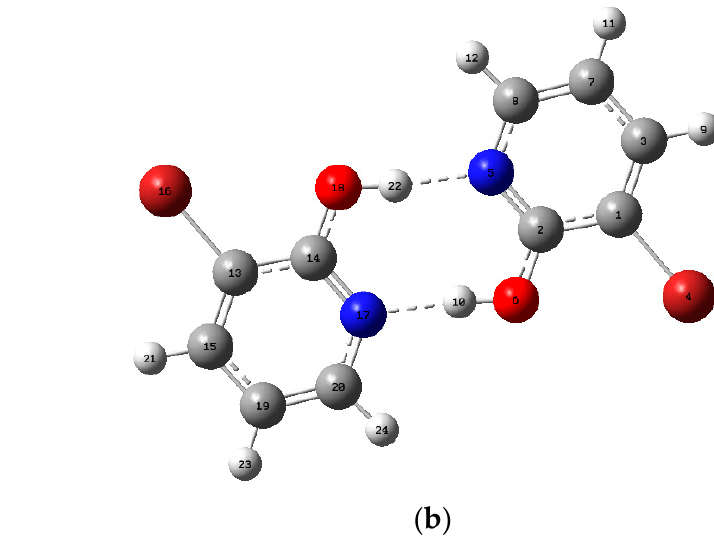
Figure 2. Theoretical optimized geometry of the 3-Br-2-HyP molecule of the monomer ( a ) and dimer ( b ) with labeling atoms calculated by DFT method.